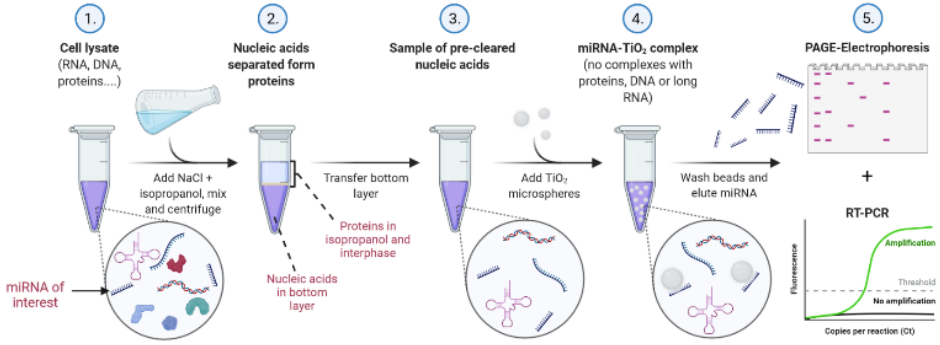
Figure 1. The scheme of the newly developed method for miRNA isolation from a complex biological sample. Created in Biorender.com.